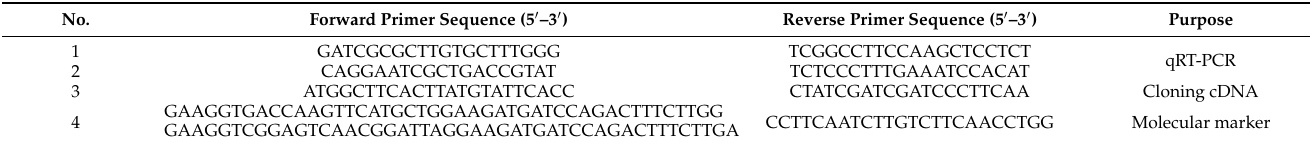
Table 1. The primer sequences used in this study. During the qRT-PCR experiment, primer 1 was used to amplify the target gene, and primer 2 was the primer of the reference gene. Primer 3 was used to clone the cDNA of NY18 and yl1 . Primer 4 was the primer sequence of functional marker